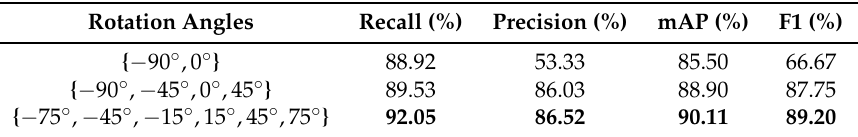
Table 4. Experimental results of rotation angles.